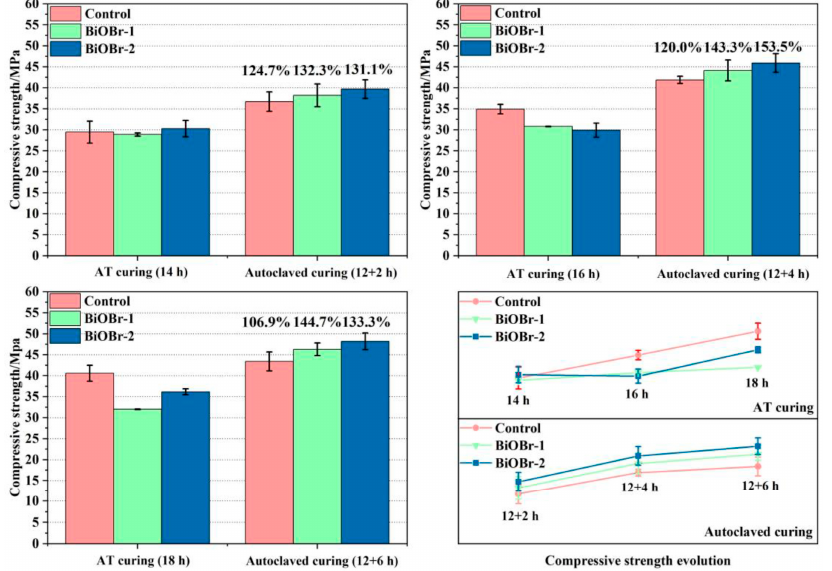
Figure 9. Compressive strength evolution of samples. (AT: ambient temperature. AT curing samples represent standard curing for different time, and Autoclaved curing samples represent autoclaved curing for different time after standard curing for 12